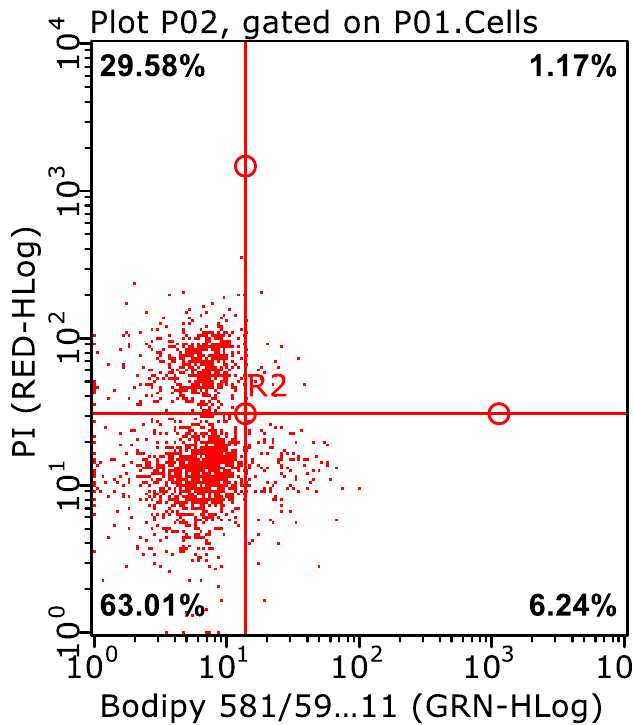
Figure 9. An example of a dot plot with live spermatozoa without lipid peroxidation in the Control group in the lower left quadrant (63.01%): PI-/BODIPY- (PI, propidium iodide; BODIPY, fluorescent membrane probe).